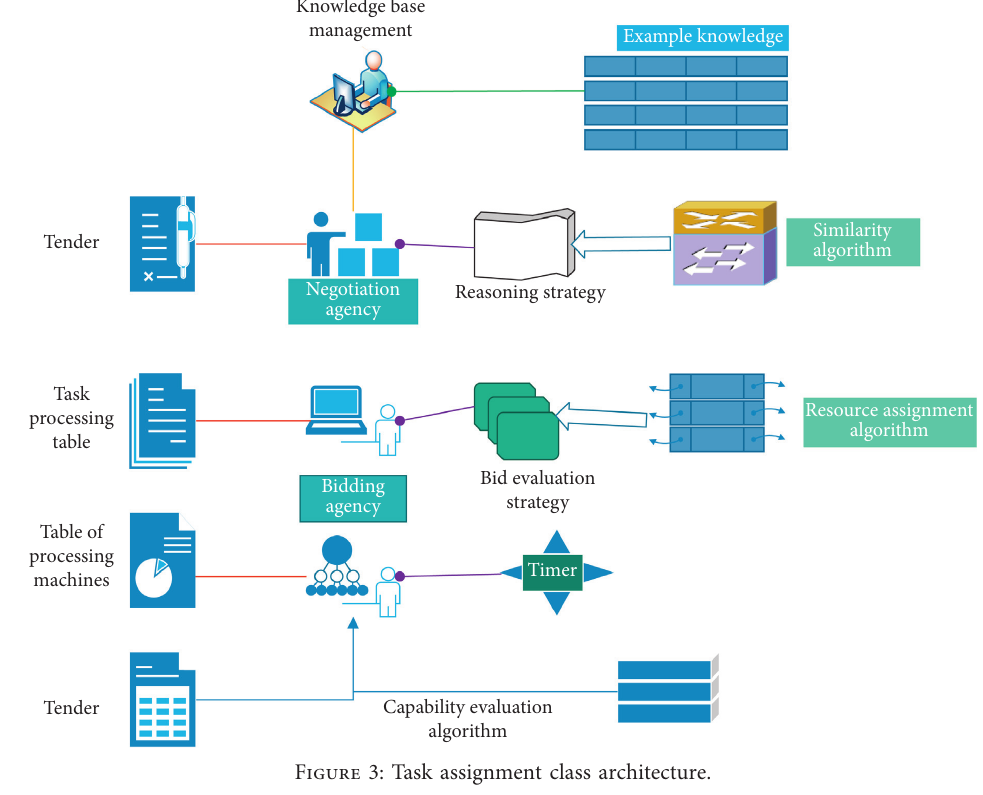
Figure 3: Task assignment class